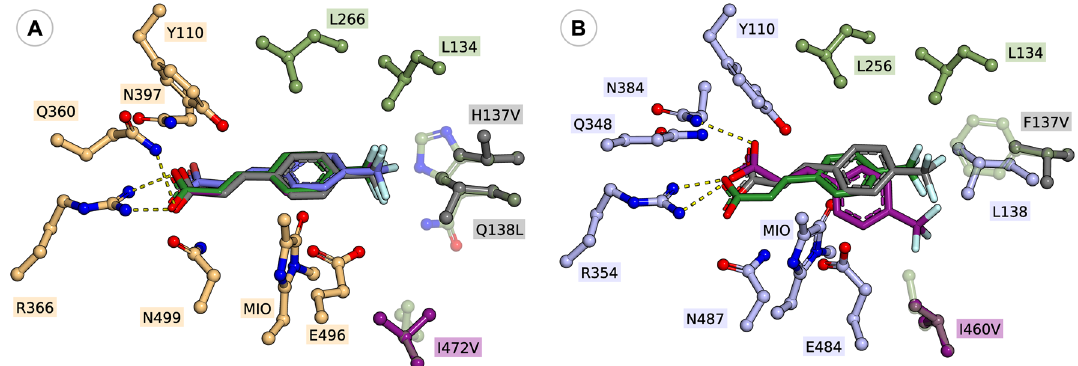
Figure 5. Active orientations of 4-(trifluoromethyl) cinnamic acid 2j within ( A ) wt - Rt PAL (green, − 5.5 kcal/ mol), H137V Rt PAL (indigo, − 6.9 kcal/mol), H137V/Q138L Rt PAL (grey, − 7.5 kcal/mol), and I472V Rt PAL (purple, − 5.5 kcal/mol) and ( B ) wt - Pc PAL (green, − 4.8 kcal/mol), F137V Pc PAL (grey, − 8.9 kcal/mol), and I460V Pc PAL (purple, − 6.4 kcal/mol). The modified residues and the active site orientation of 2j within the corresponding variant is marked with similar colour.